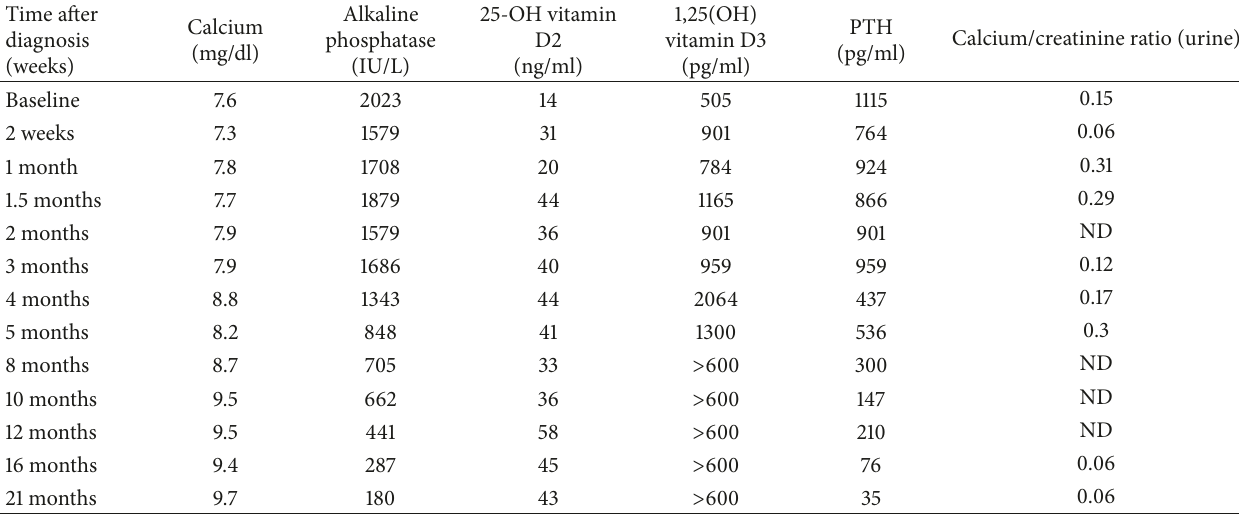
Table 1: Metabolic parameters on diagnosis and during